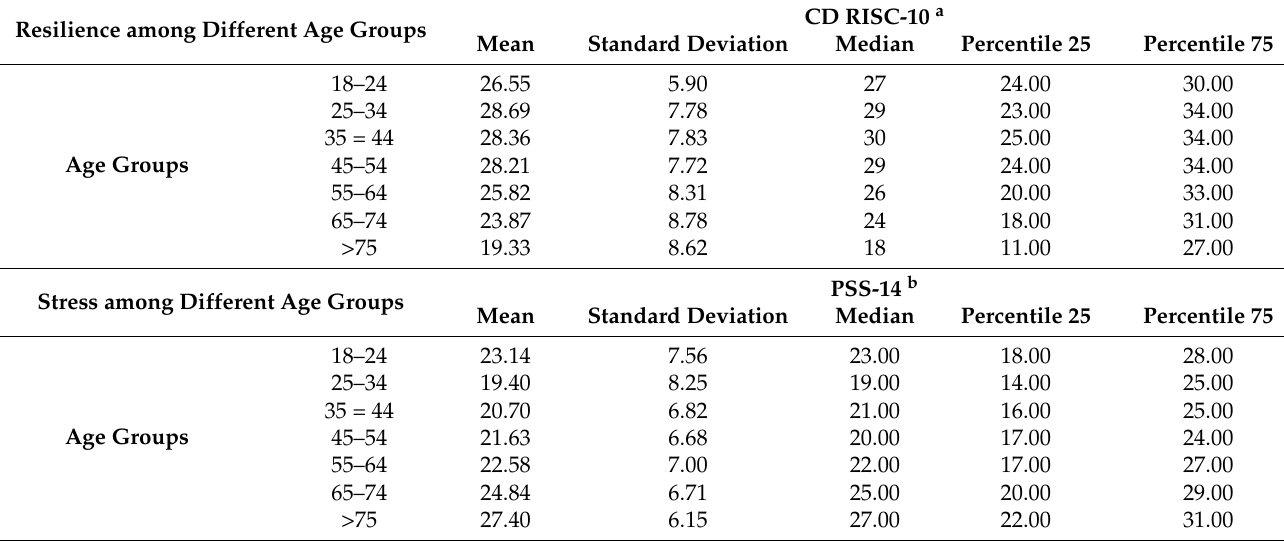
Figure 5. Resilience level. Q1 = lowest quartile (1 to 25%) scored between 0 and 21; Q2 = the second quartile (26 to 50%) scored between 21 and 27.5; Q3 = the third quartile (51–75%) scored between 27.5 and 33; Q4 = the top quartile (76–100%) scored between 33 and 40. Table 4. Resilience and perceived stress levels among different age